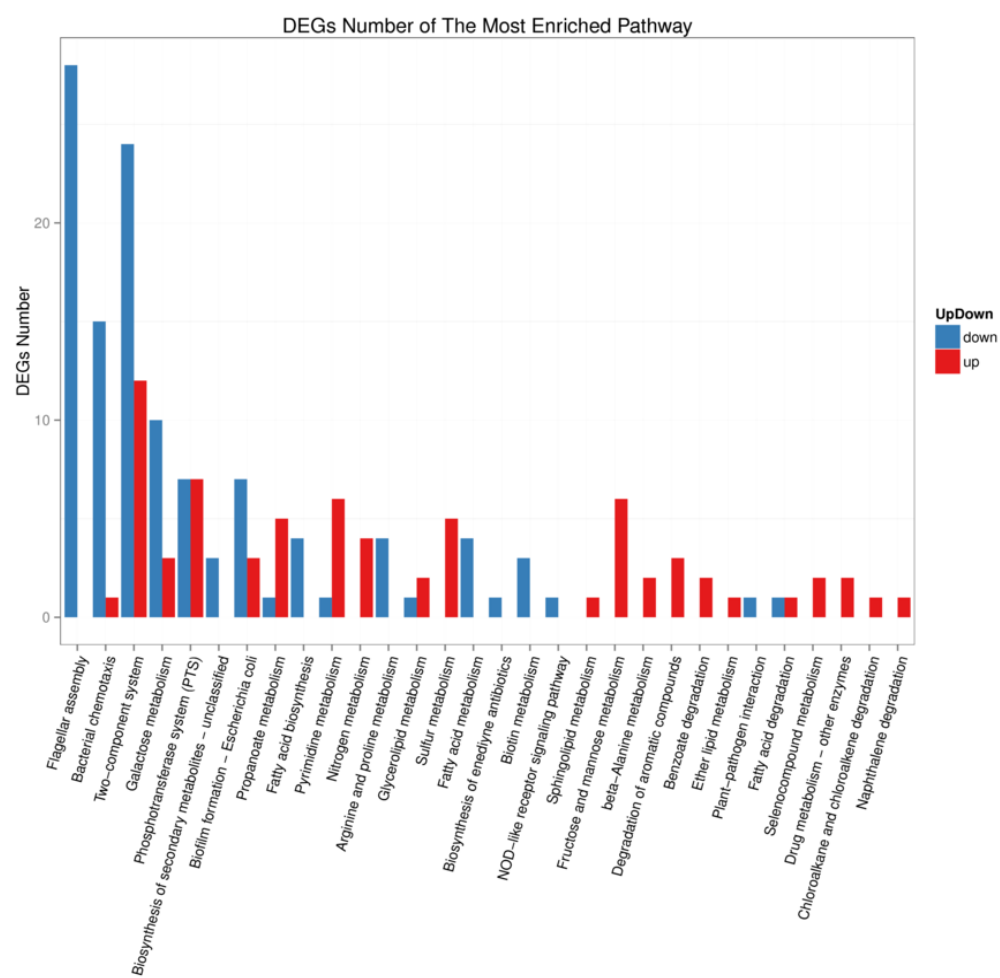
Figure 6. KEGG pathway classification analysis of wild-type AE81 and mutant AE81 ∆ ygeK strains. Downregulated genes indicated in blue, and upregulated genes in red.